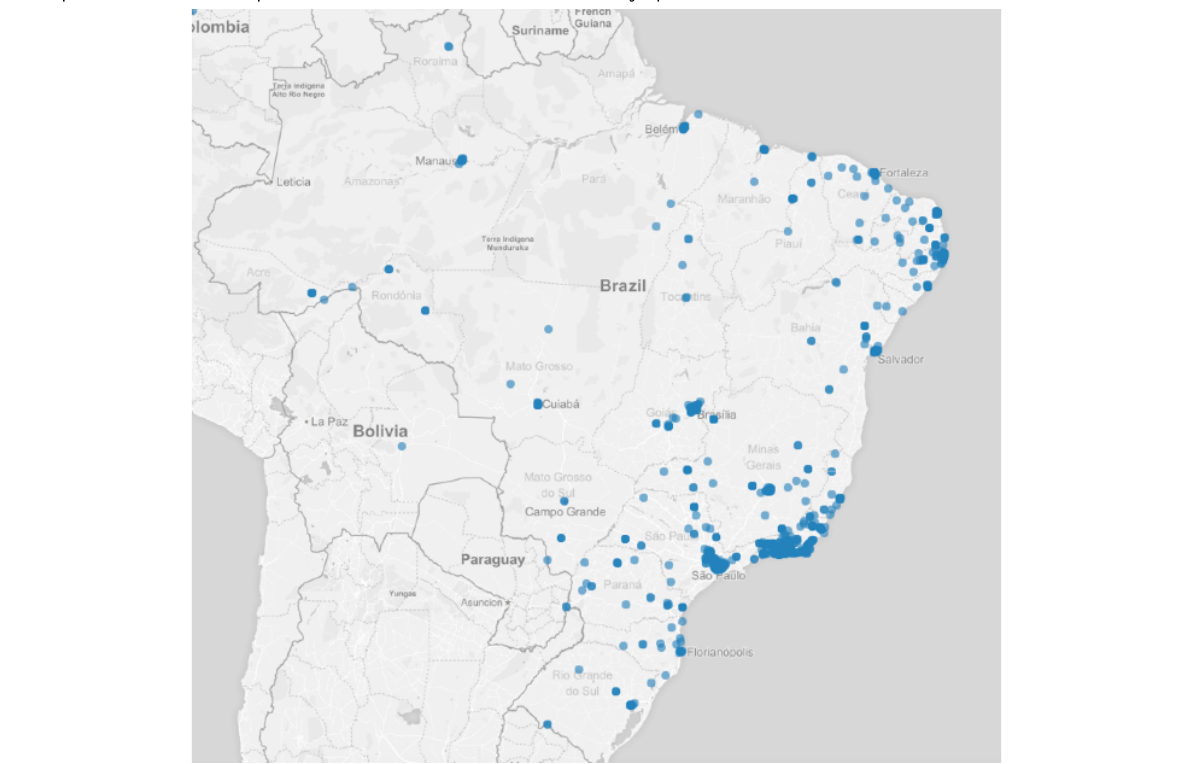
Figure 4. Spatial distribution of reports from Guardians of Health users with symptoms.